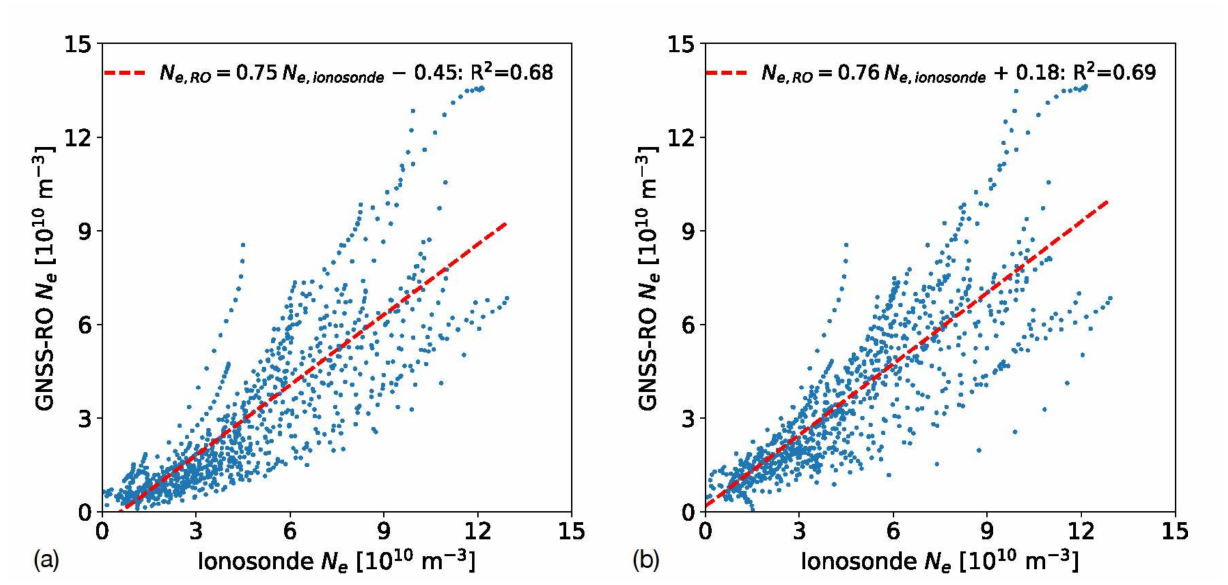
Figure 15. Scatter plot of the electron densities predicted for each GNSS-RO altitude within the ionosonde f min altitude and h m E . The ionosonde profiles are interpolated at each RO altitude for comparison. Unshifted profiles are compared in ( a ), while the ionosonde profiles shifted in altitude are displayed in ( b ). The linear regression parameters are also shown for both panels.